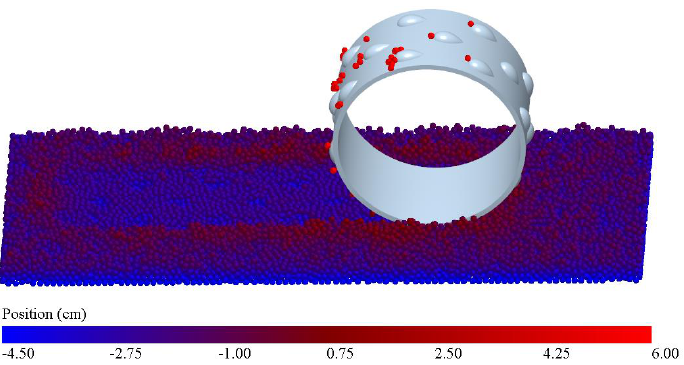
Figure 8. Soil dynamic process of the press roller.